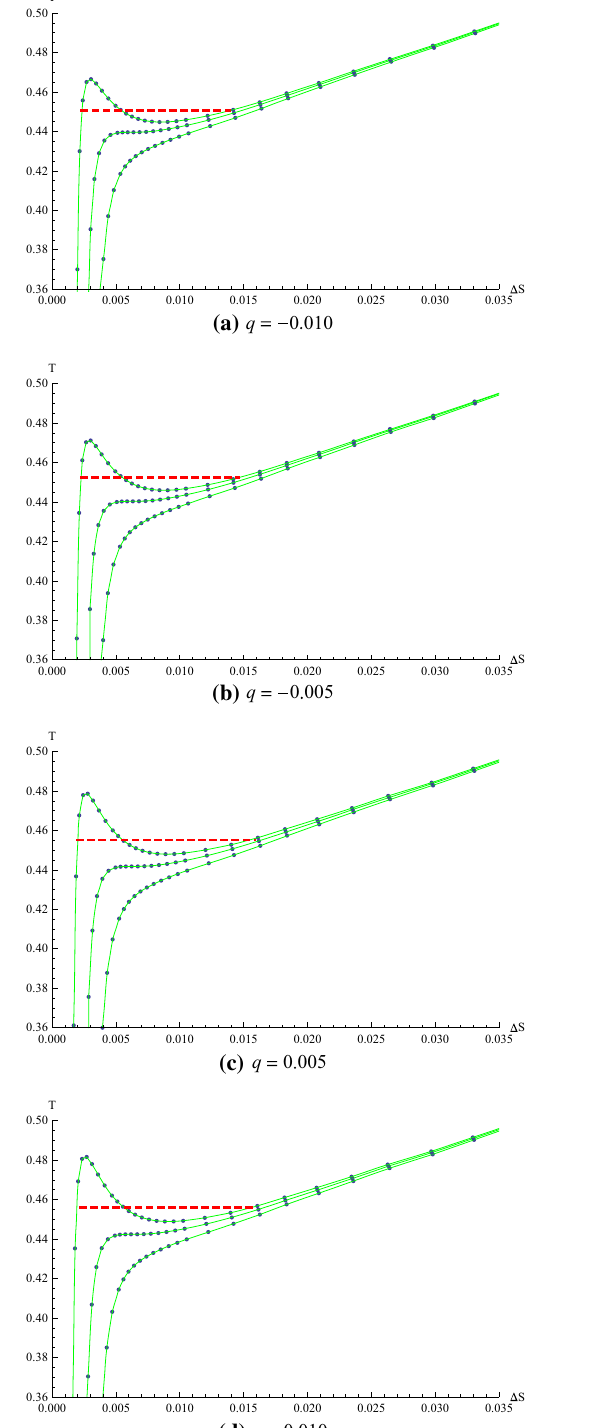
Fig. 5 Plots of isocharges in the T – (cid:8) S plane for ϕ 0 = 0 . 45. The red dash line corresponds to the temperature of the first order phase transition. The values of the electric charge chosen (from top to bottom) are the same as the ones in Fig. 1